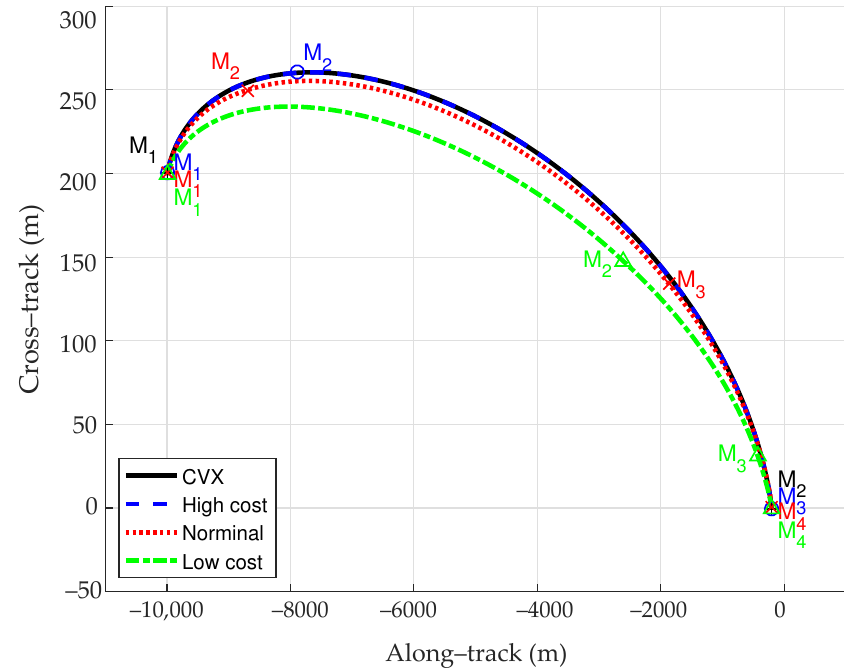
Figure 3. Optimal trajectories (out-of-plane) when t f = 2000